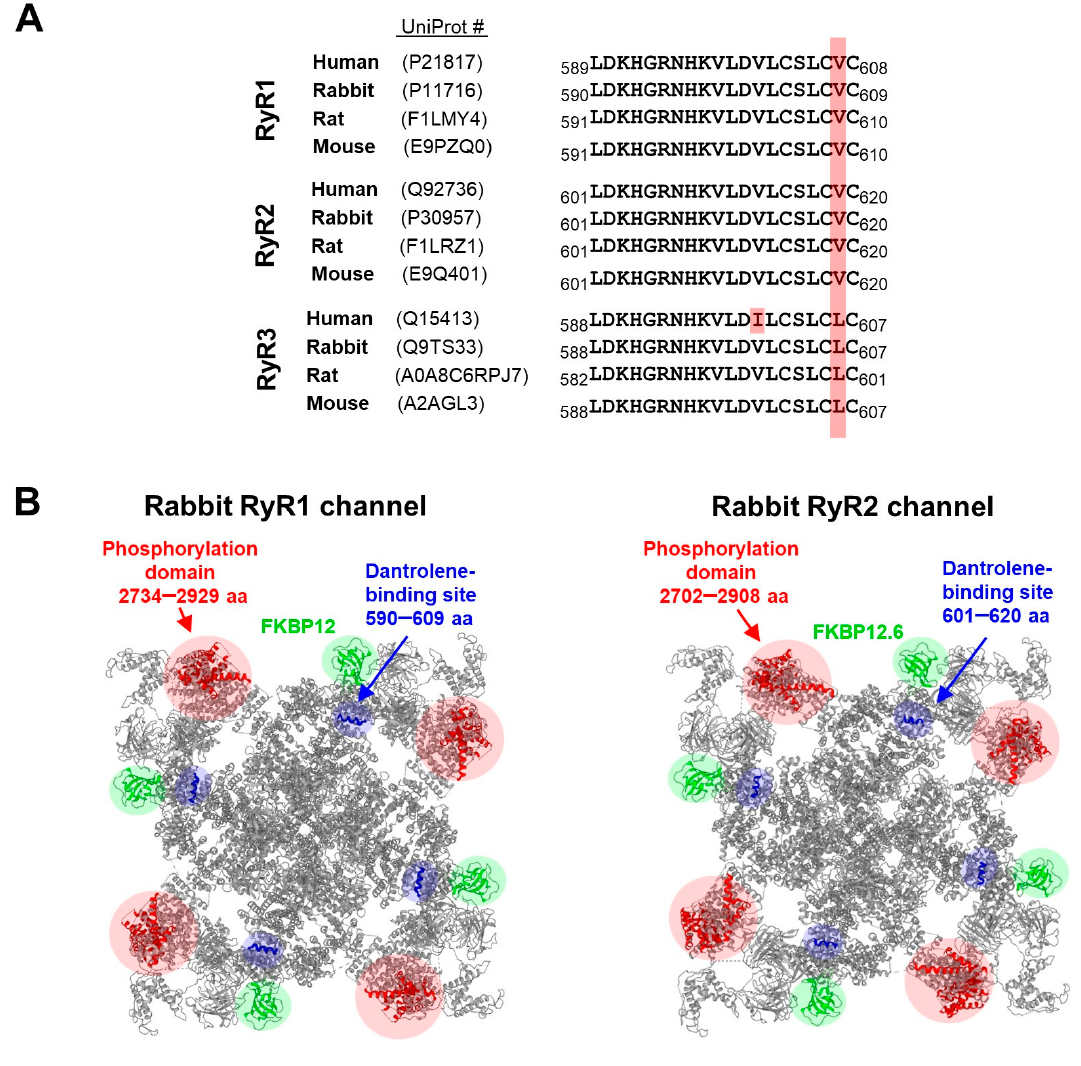
Figure 1. Structural aspects of dantrolene interaction with RyR isoforms. ( A ) A multiple-sequence alignment of the dantrolene-binding sequences located within all three RyR isoforms [19,160] from indicated mammals. The non-conserved residues are boxed in red. The sequences were taken from the UniProtKB database. ( B ) Cryo-EM 3D maps (cytosolic view) of the rabbit RyR1 (left) and the rabbit RyR2 (right) channels. The dantrolene-binding site is shown in blue [19,160], the phosphory- lation domain in red [174], and FKBP12/12.6 in green [197,198]. ( C ) Zoomed-in view of the DR2 in one of four RyR1 (left) and RyR2 (right) subunits shown in magenta [199]. As the DR2 region is structurally unresolved, we highlighted two β -sheets within RyR1 ( β 1:1287 − 1290 aa and β 2:1438 − 1439 aa), as well as RyR2 ( β 1:1300 − 1304 aa and β 2:1426 − 1431 aa) subunits that closely sur- round the DR2 region. The dantrolene-binding site in blue and FKBP12/12.6 in green are also shown. The cryo-EM 3D structure of RyR1 (PDB ID: 3J8H [198]) and RyR2 channels (PDB ID: 5L1D [197] were taken from the Protein Data Bank available at rcsb.org [200]. UniProt #, UniProt accession number.